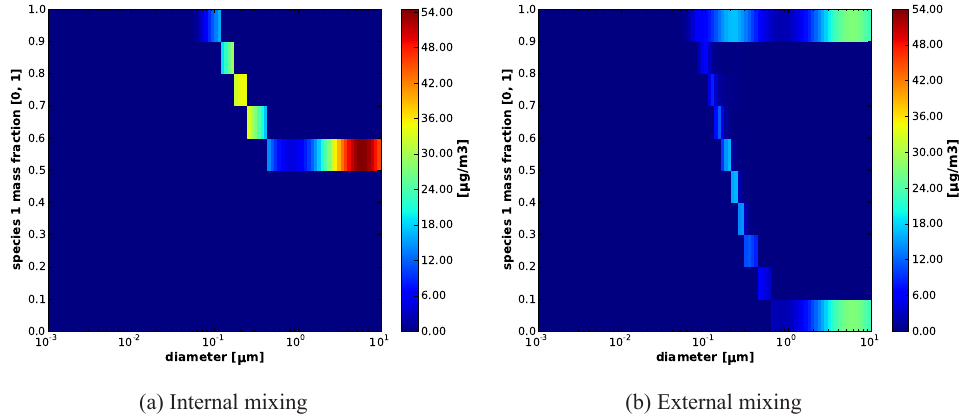
Figure 4. Distribution after 12h: particle mass concentration as a function of diameter and mass fraction of species 1.